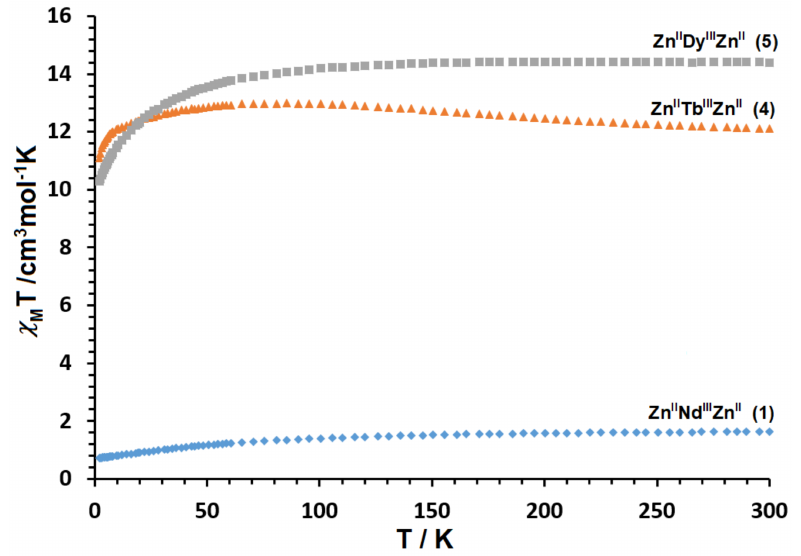
Figure 8. Temperature dependence of experimental χ M T versus T for 1 (Zn II –Nd III –Zn II ), 4 (Zn II –Tb III –Zn II ) and 5 (Zn II –Dy III –Zn II